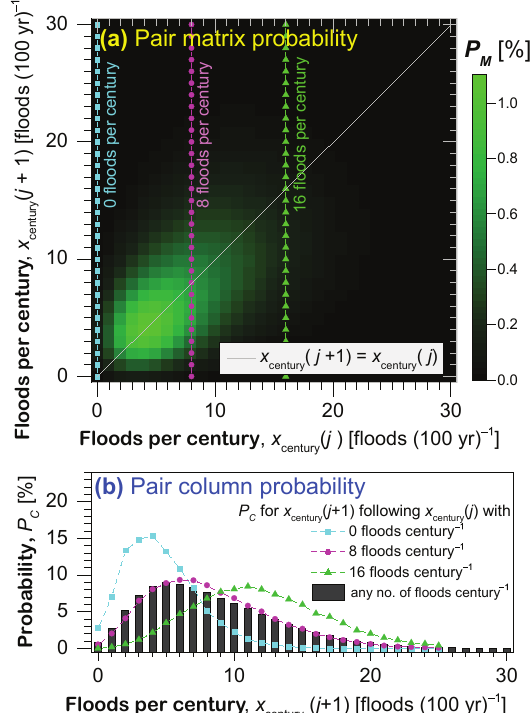
Figure 16. Using the optimized POT FGN + Period model for fore- casting the number of floods in 1 century based on the number of floods in the previous century: based on the palaeoflood model realizations for 10 9 years are shown (a) the 2-D probability of the number of floods per century ( x century (j)) and the number of floods in the succeeding century ( x century (j + 1)) (background grid colours; see the legend for the scale). The solid grey diag- onal line represents the equality of the number of floods in both centuries ( x century (j + 1 ) = x century (j)) . (b) The 2-D probability distribution shown in (a) is cut vertically at x century = 0, 8, and 16 floods century − 1 and the corresponding probability densities of floods per centuries after a century with x century = 0, 8, and 16 floods century − 1 are presented as coloured lines (see the leg- end). Also given is the probability density of floods per century of the palaeoflood